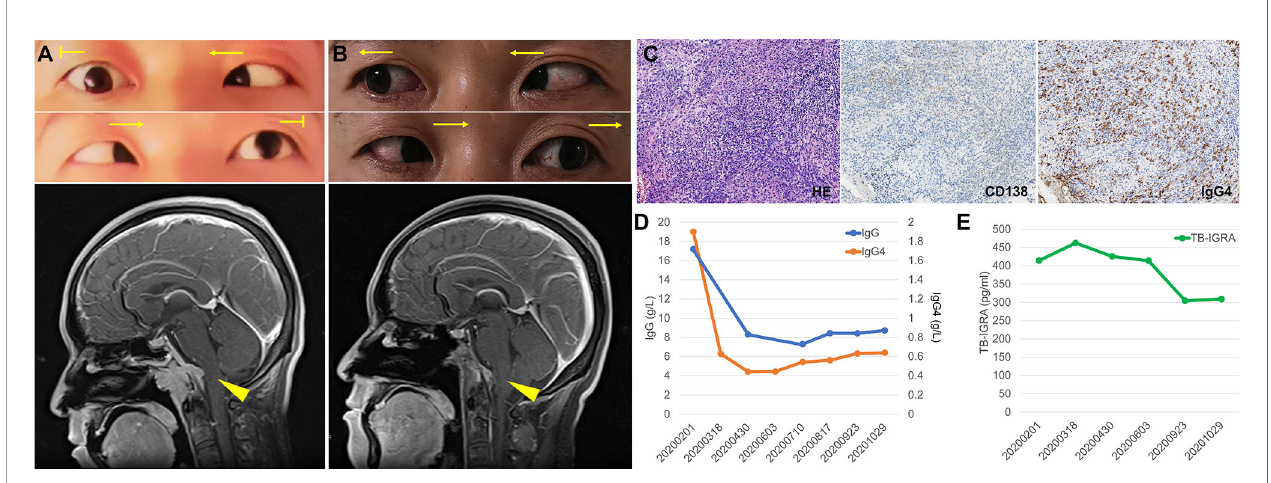
FIGURE 1 | Imaging, histologic and laboratory fi ndings of the case. (A) The abduction of both eyes was limited (arrows indicate the direction of movement), and contrast-enhancing brain magnetic resonance imaging (MRI) showed a 3.8×2.9×2.9 cm mass overlying clivus with dural tail sign (arrow head). (B) Abduction of both eyes recovered after treatment and MRI showed the mass in the clivus area was remarkably smaller. (C) Histologic features of the lesion revealed fi bro-connective tissue with mixed in fl ammation containing predominantly plasma cells and immunochemical analysis revealed an increased number of IgG4-positive plasma cells (×200). (D, E) Serum levels of IgG and IgG4 (D) and T cell-released INF- g in TB-IGRA (E) of the patient during the